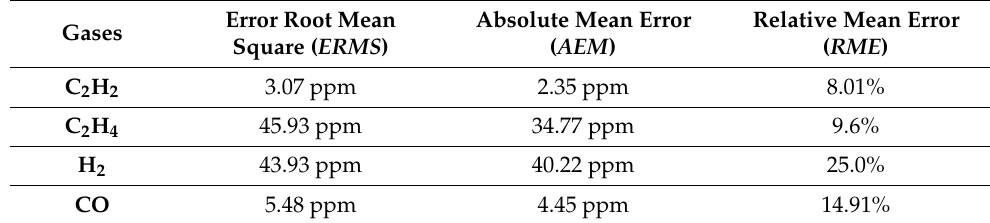
Table 20. Mismatch between online and offline measurements of gas